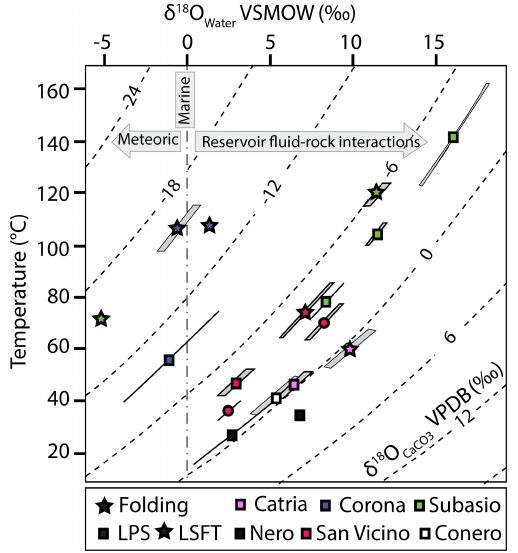
Figure 8. Plot of δ 18 O fluid (‰VSMOW) vs precipitation temper- ature ( ◦ C) obtained from clumped-isotope analyses along with un- certainties reported as greyed contours. Dotted oblique lines are the measured δ 18 O CaCO of the vein cements (‰VPDB). Shape of the 3 points correspond to tectonic set (layer-parallel shortening being U1 and compatible faults and folding U2), while filling colour relates to structure. LPS stands for layer-parallel shortening; LSFT stands for late-stage fold